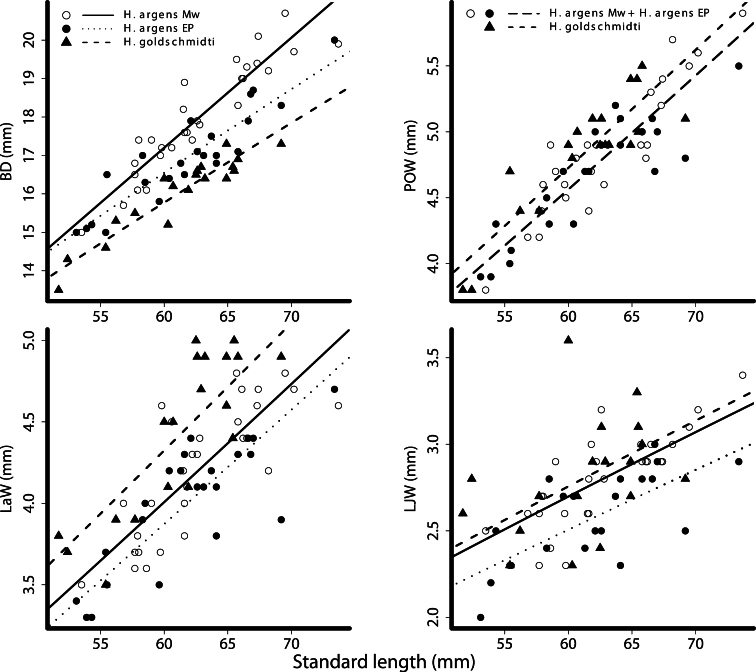
Plots of taxonomic measurements as a function of standard length. Body depth (BD), preorbital width (POW), lower jaw width (LJW) and lachrymal width (LaW). Open circles - Haplochromis argens from the Mwanza Gulf (Mw); closed circles - Haplochromis argens from the Emin Pasha Gulf (EP); triangles - Haplochromis goldschmidti. Power curves determined from GLM parameter estimates, solid line - Haplochromis argens from the Mwanza Gulf; dotted line - Haplochromis argens from the Emin Pasha Gulf; dashed line - Haplochromis goldschmidti, long dashed line (POW) - Haplochromis argens from both locations (MW + EP).